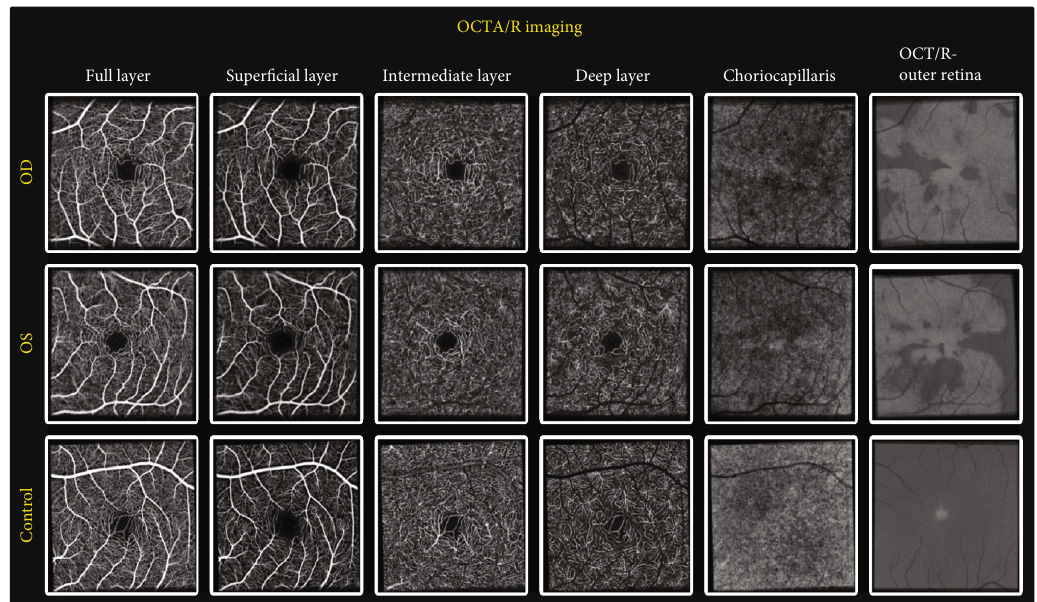
Figure 2: Optical coherence tomography angiography (OCT-A) of both eyes compared to healthy control, demonstrating choriocapillaris fl ow voids that roughly correspond to the overlying macular lesions seen on the infrared re fl ectance photographs, supporting the hypothesis that these represent areas of relative ischemia.